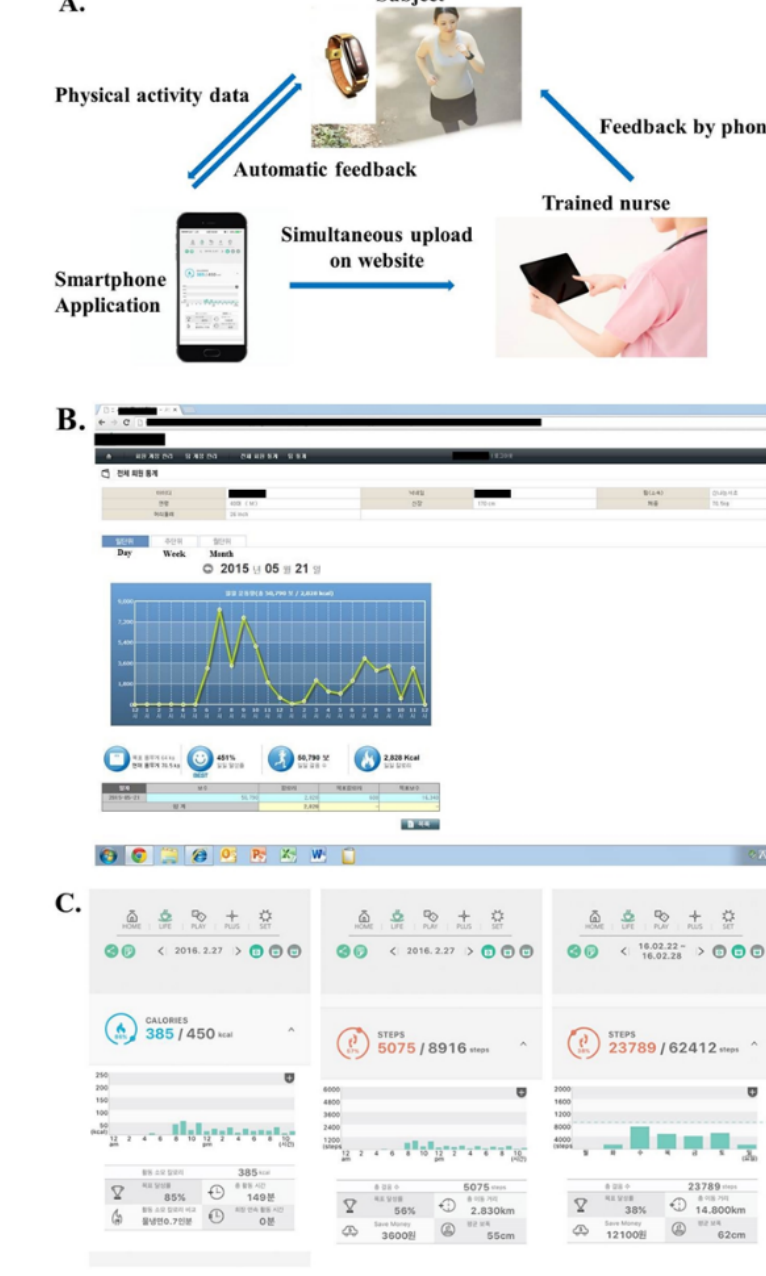
participants’ age between those who did and did not complete the intervention (mean 51.97, SD 8.49 years vs mean 44.20, SD 9.55 years; P =.003) (Table 1). The majority of participants ceased monitoring their exercise within the first few weeks of the study (Figure 3) primarily due to miscommunication between their mobile device and the wearable device. Only five of the participants who completed the trial (n=20) responded that they had regularly exercised at baseline, whereas 55% (11/20) of them had been physically